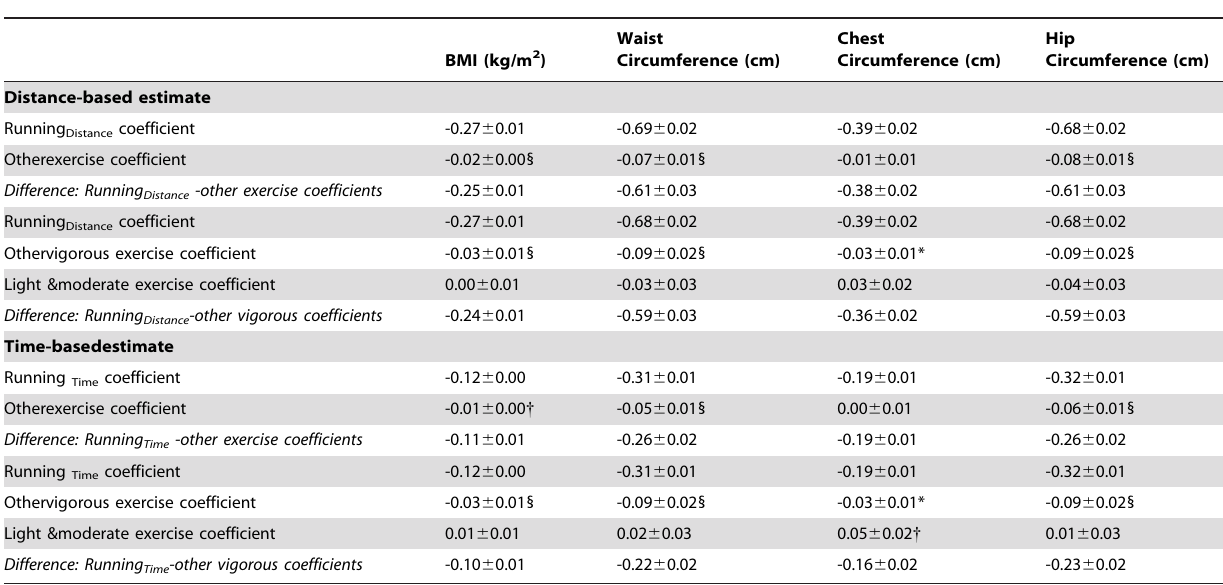
Table 3. Cross-sectional regression slopes ( 6 SE) of BMI and body circumferences (dependent variables) versus METhours per day of running and other physical activities (independent variables) in females.